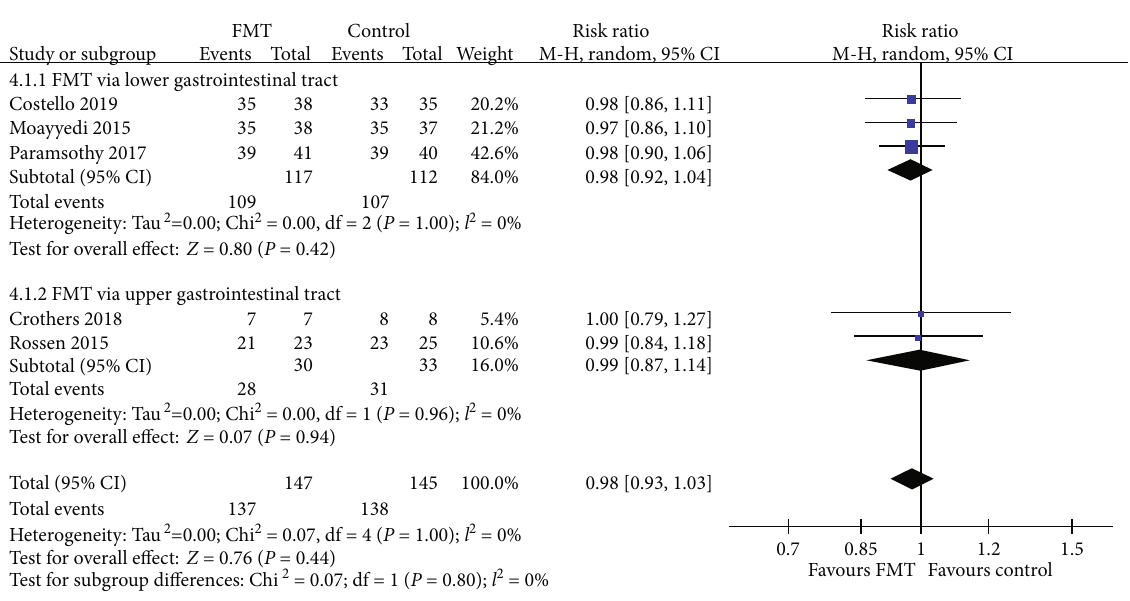
Figure 12: Forest plot of studies reporting serious adverse events and subgroup analysis according to di ff erent delivery routes.